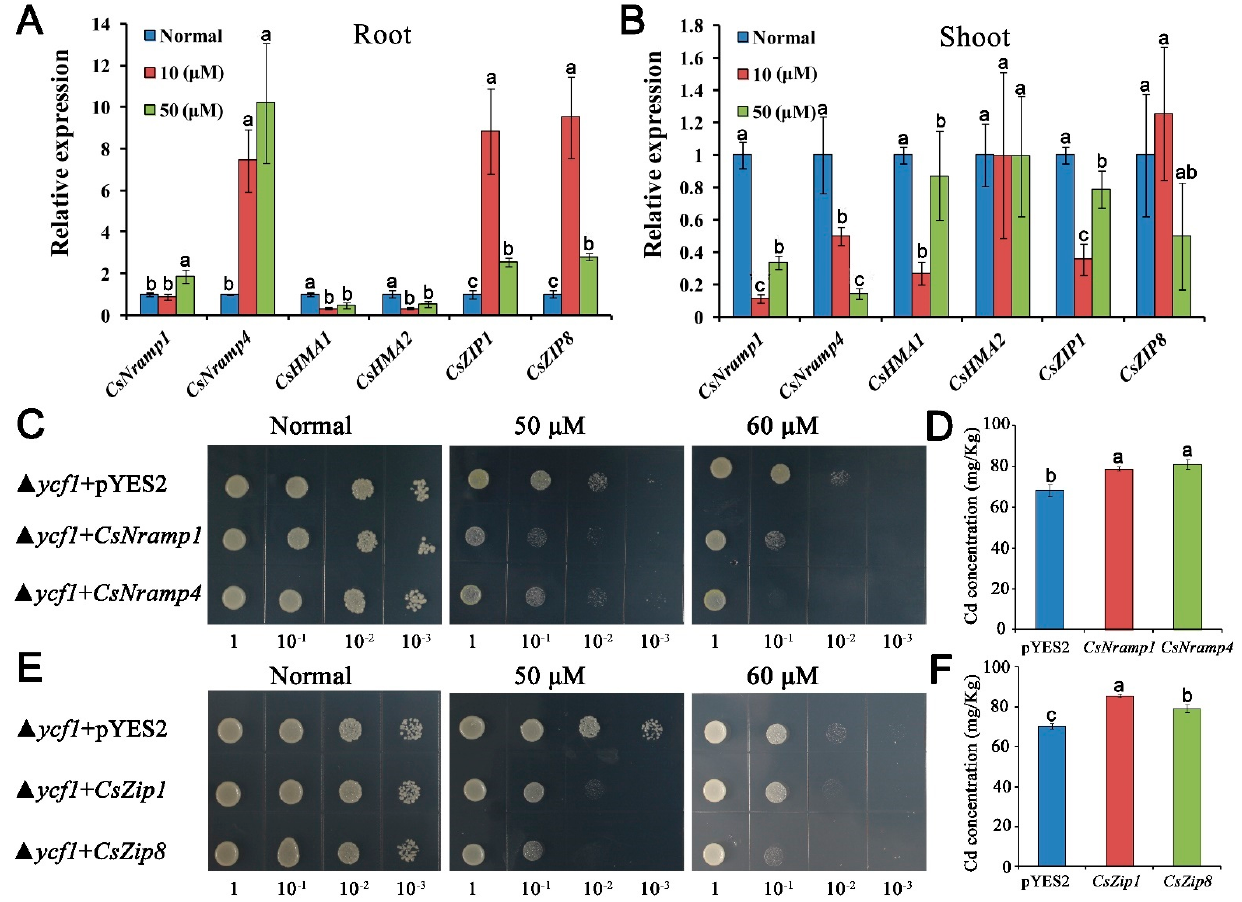
Figure 3. Profiling of gene expression and metal transport capacity of representative genes coding for potential Cd transporter. ( A , B ) qRT-PCR analysis of transcript abundance of CsNramp1 , CsNramp4 , CsHMA1 , CsHMA2 , CsZIP , and CsZIP8 in cucumber root ( A ) and shoot ( B ) under Cd exposure. Ten-day-old seedlings were exposed to 0, 10, or 50 μ M Cd (+Cd) for 4 d. Vertical bars represent standard deviation (SD) of the mean of three biological replicates ( n = 5 seedlings). Different letters on the bars indicate a significant difference ( p < 0.05) between the treatments. ( C – F ) Expression of CsNramp1, CsNramp4, CsZIP1, and CsZIP8 in yeast cells to determine the activity for Cd detoxification. All cell types were grown in YNB medium supplemented with or without 50 or 60 μ M Cd for 3 d. ( C , E ) Growth response to Cd was determined by comparing transformed and untransformed yeast. D and F: Clones described in the liquid cultures were diluted to OD 0.2 in fresh SD/ura medium, and the Cd concentration in the cells was determined by ICP-MS. Vertical bars represent the standard deviation of three replicates. Different letters on the bars indicate that mean values are significantly different between transformed and untransformed cells ( p < 0.05).